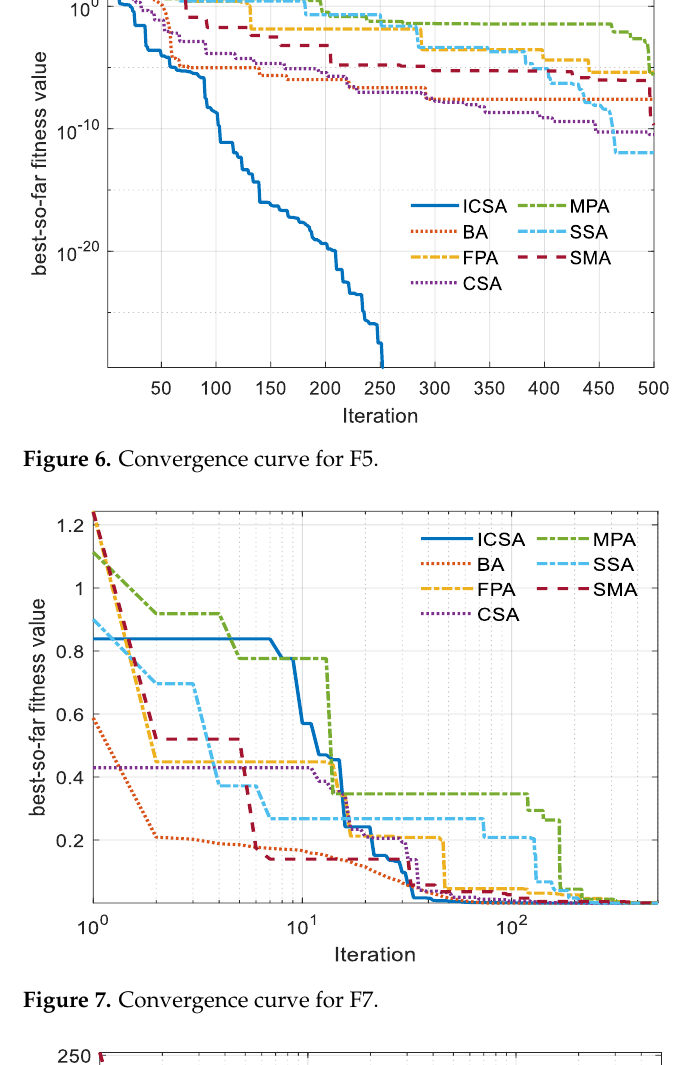
Figure 5. Convergence curve for F4.